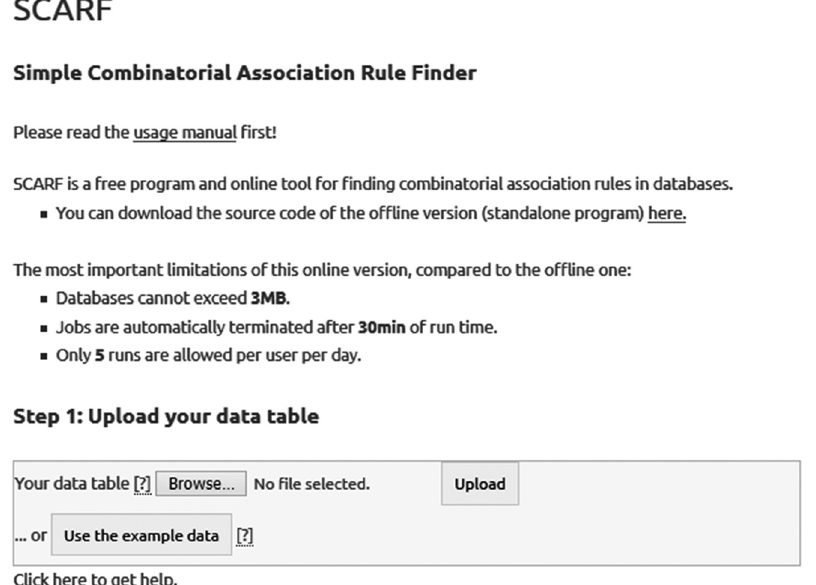
Figure1: Theinputscreenofthe SCARF